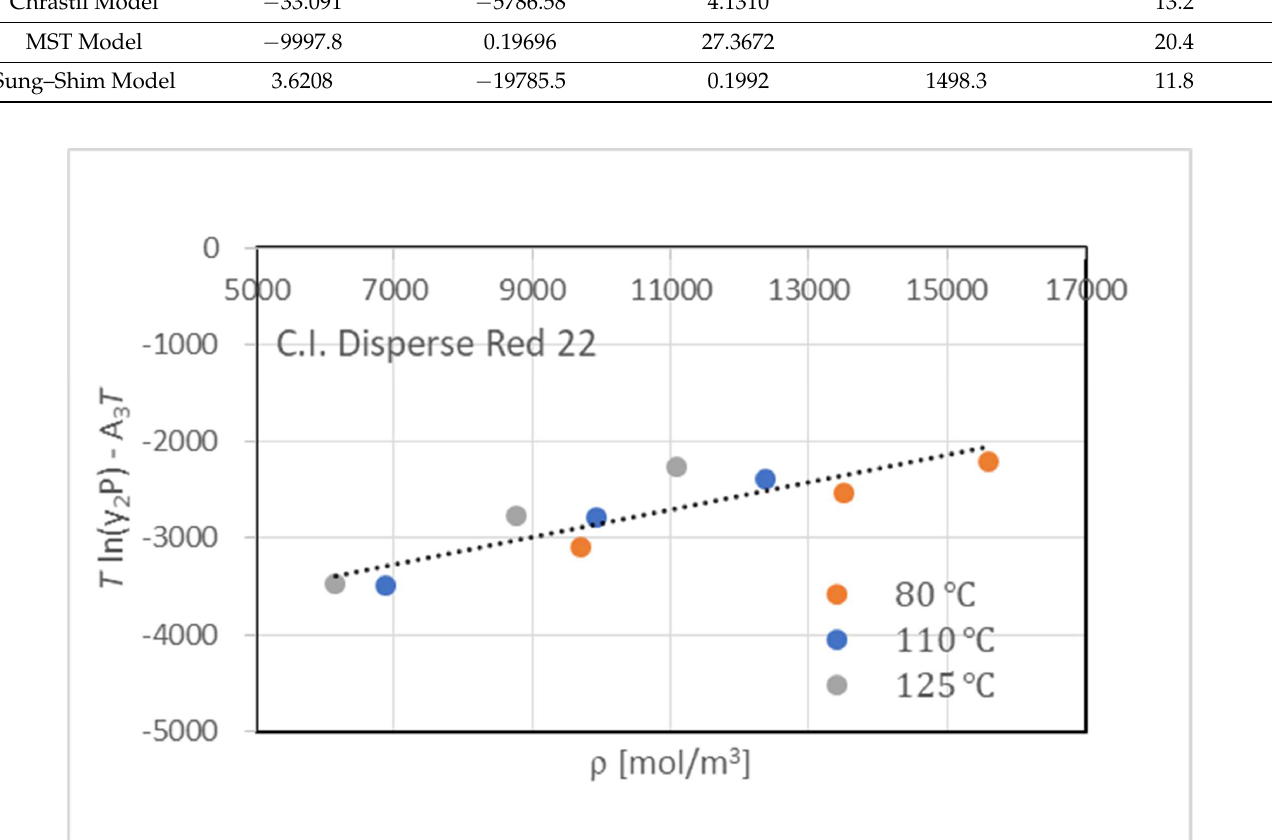
Figure 4. Solubility of C.I. Disperse Red 22 in scCO 2 correlated by MST model.